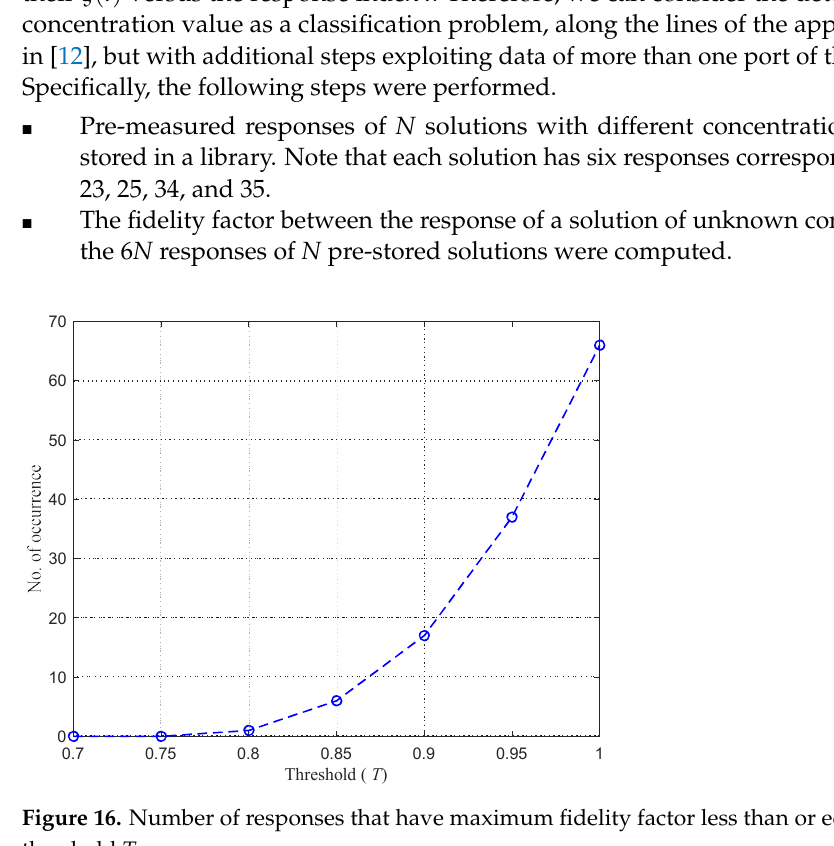
Figure 17. Responses that have maximum fidelity factor less than or equal to 0.85. The concentration of pre-stored response, the fidelity factor of which with the re- sponse to unknown solution is the maximum, is considered the unknown concentration of the solution under measurement. Note that the use of the Rotman lens increased the reliability of concentration determination as the number of responses with which the un- known response was cross-correlated increased sixfold. For more accurate results, more responses of the Rotman lens can be seen in Table 4. For T = 0.9, there are 17 responses, which can be exploited in determining the unknown concentration. 5. Conclusions In this effort, and for the first time, we investigated the performance of a Rotman lens as a sensor. The proposed sensor operates in the mmW band with a center frequency of 28 GHz. The Rotman lens sensor consists of five beam ports, six array ports, and four dummy ports. Each port was analyzed in terms of its s-parameters and mutual coupling.